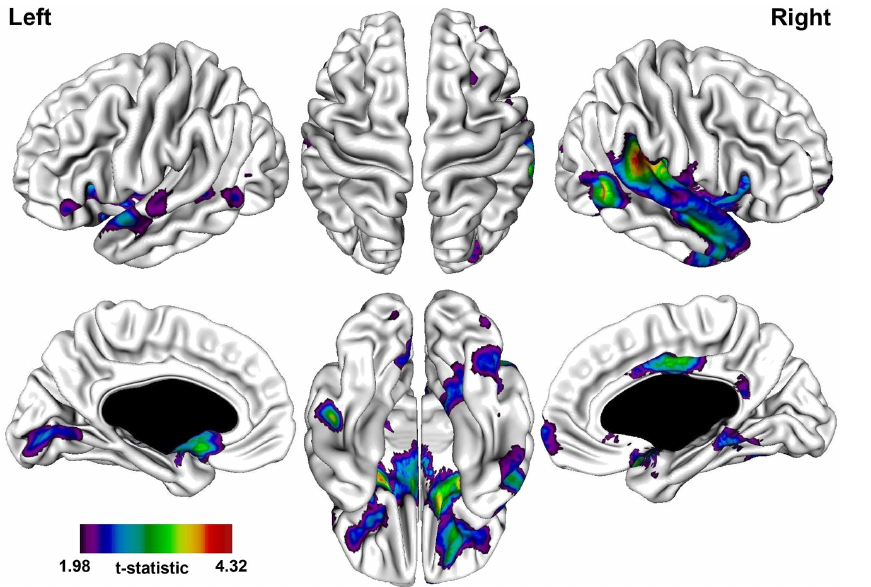
Figure 1. t-statistical brain maps showing cortical thinning in patients with persistent negative symptoms compared to patients without persistent negative symptoms. Most pronounced differences in the right temporo-parietal junction, right superior temporal gyrus, right parahippocampal gyrus, and left inferior frontal gyrus. The colour bar indicates the t-value. All areas shown exceed a FDR corrected statistical threshold of P , 0.01.